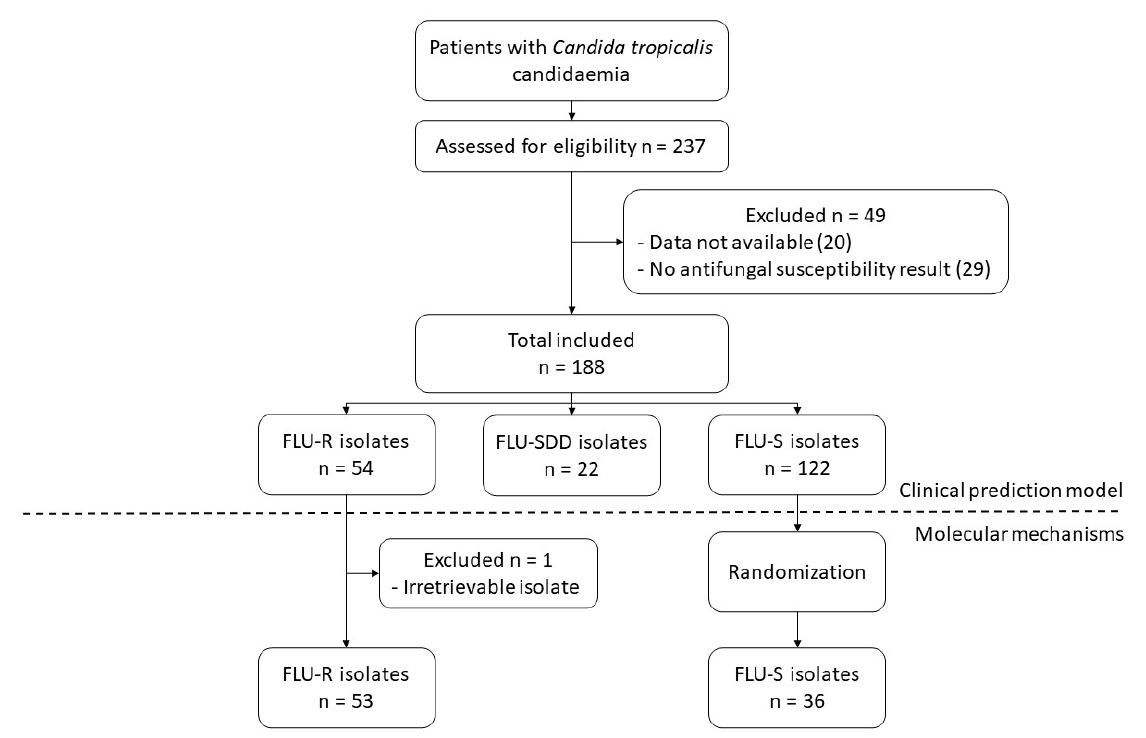
Figure 1. Flowchart of the study (Abbreviation: FLU-R, fluconazole-resistant; FLU-SDD, fluconazole susceptible-dose dependent; FLU-S, fluconazole-susceptible) .